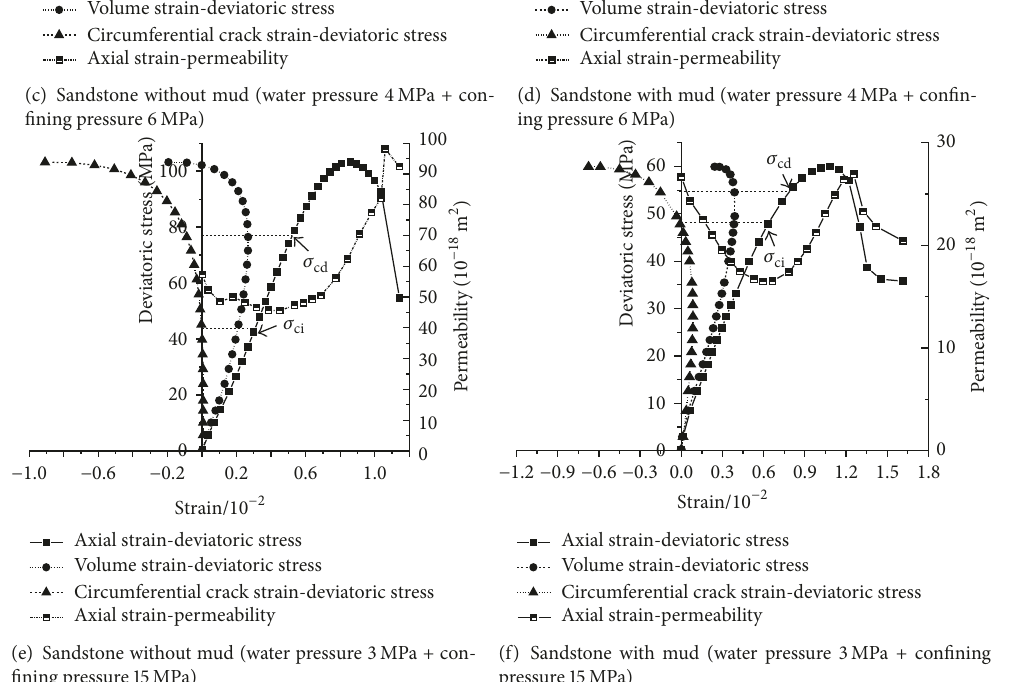
Axial strain-deviatoric stress Volume strain-deviatoric stress Circumferential crack strain-deviatoric stress Axial